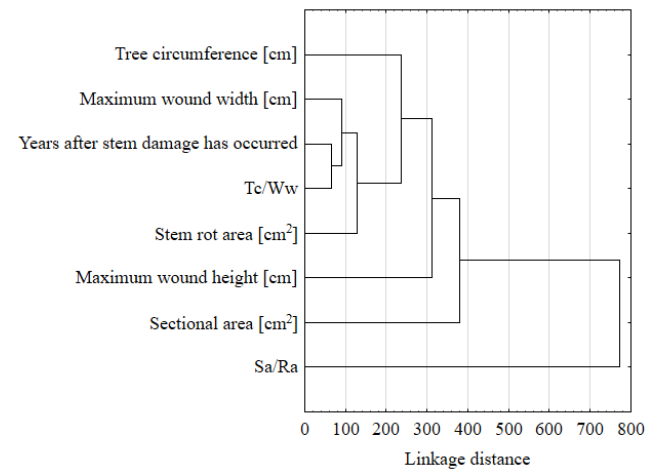
Figure 3. Agglomeration using the single linkage